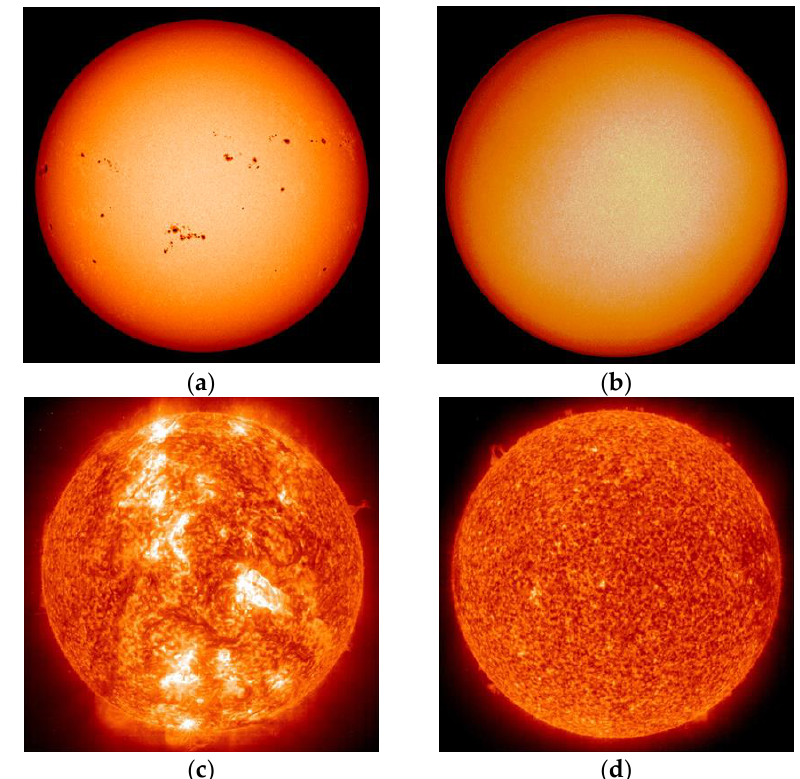
Figure 1. ( a , c ): the Sun during solar maximum (19 July 2000), with high sunspot numbers (SSN); ( b , d ): the Sun during solar minimum (18 March 2009), with low SSN [3].